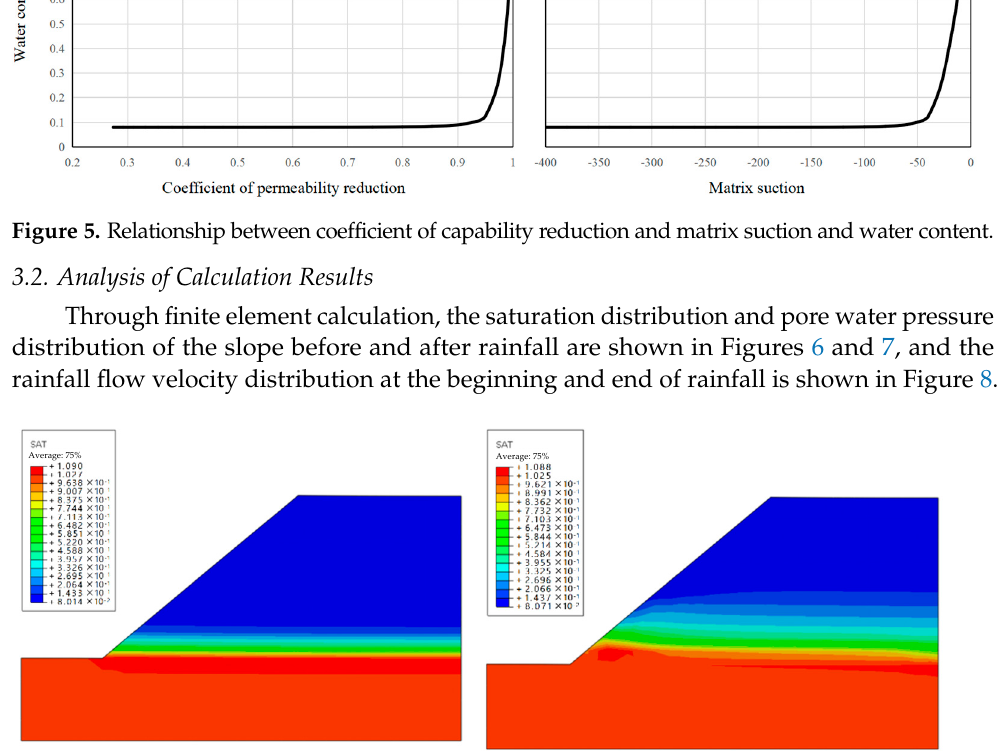
Figure 6. Saturation distribution of slopes before and after rainfall.